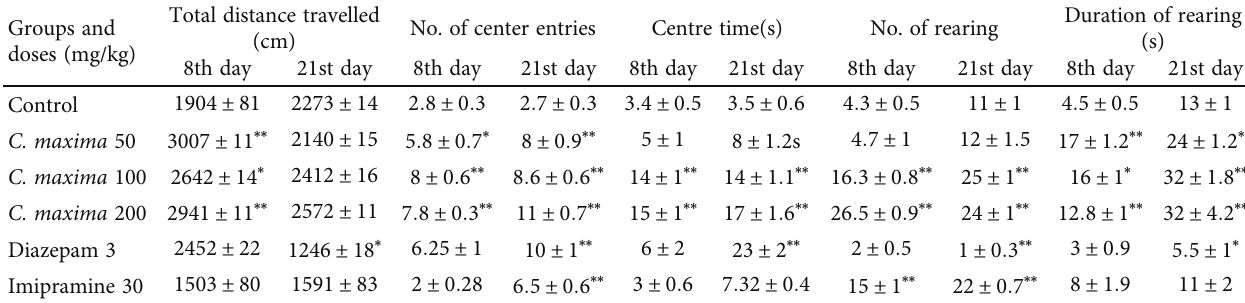
Table 9: Outcome of C. maxima seeds in open fi eld test.